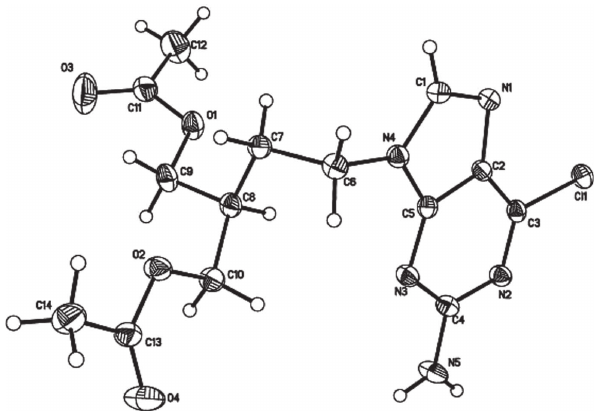
Table 2: Fractional atomic coordinates and isotropic or equivalent isotropic displacement parameters (Å 2